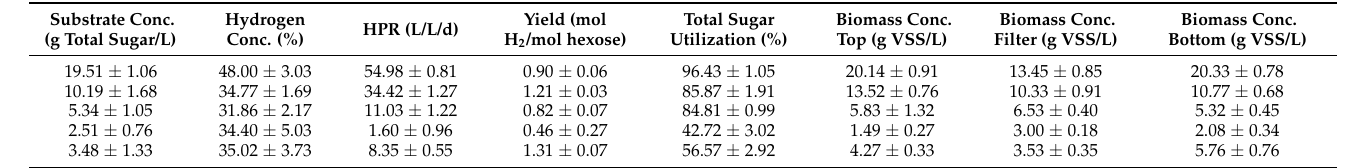
Table 2. Composition of liquid metabolites for hydrogen production in different substrate concentrations (HRT 1 h; h/H 0.5). Substrate Conc. (g Total